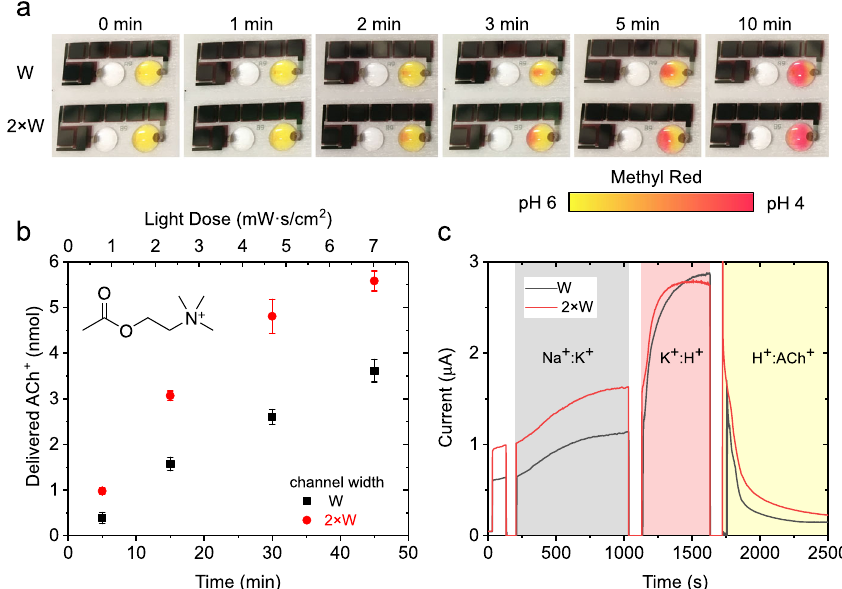
Fig. 2 Light-driven ion pump operation. a Photodriven proton-pumping experiment validated with methyl red pH indicator dye. The source reservoirs are positioned on the left, and contain 0.1 M HCl, while the target reservoirs on the right have methyl red. This dye is initially yellow but turns red with lowering pH. The ion delivery point (end of ion channel) is at the leftmost point of the target reservoir, thus the Δ pH starts there. b Acetylcholine pumping experiment, demonstrating effective OPV driven ion transport of a larger ion using the tandem series devices. Error bars = s.d. c Online current experiment on the photodriven ion pumps of the two different sizes. The ions in the source electrolyte are switched from Na + to K + to H + and fi nally ACh + . The current changes according to the ion ’ s conductivity. The mode of OPV operation is voltage-limited in case of the larger ions ACh + , Na + , and K + , but current-limited for H + . This is evident by similar levels of H + current for the devices of the two different OEIP